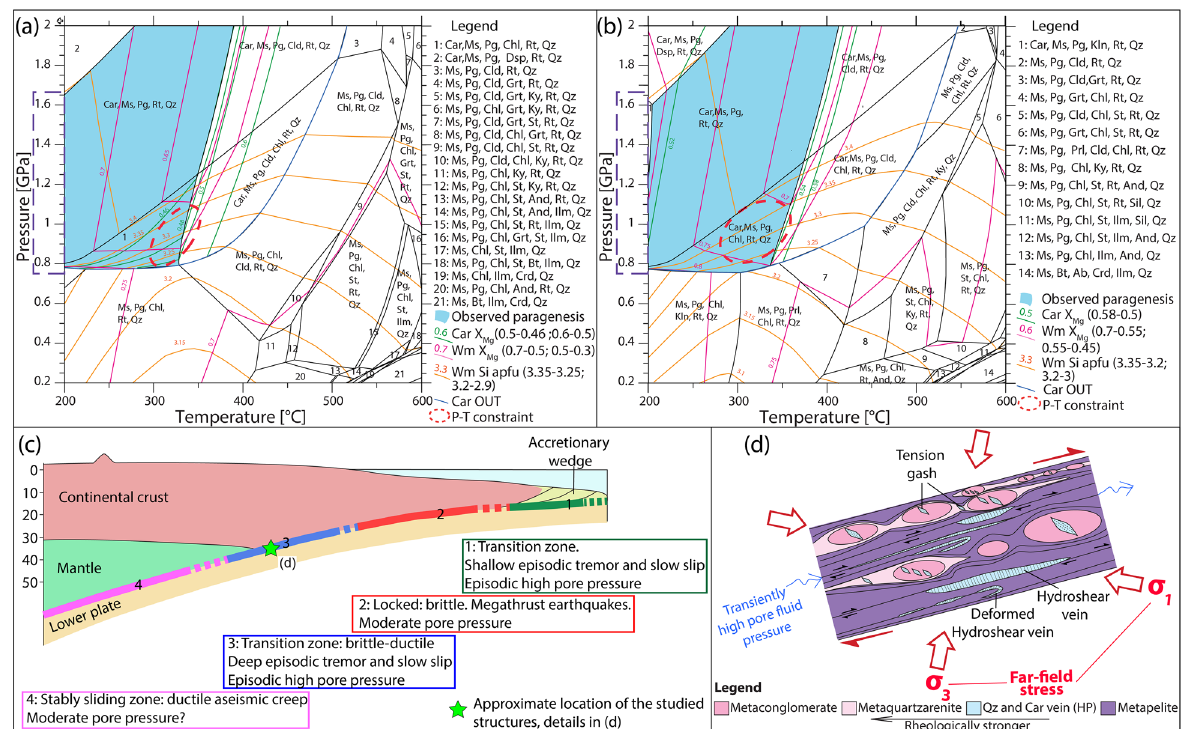
Figure 8. Thermodynamic modeling and conceptual sketch of the proposed geological record of ETS. ( a , b ) Equilibrium phase diagrams for quartz and carpholite dilational hydroshear vein (Sample A) and metapelite (Sample B), respectively. Red dashed ellipses indicate the P ‐ T conditions of the metamorphic stage best fitting the observed paragenesis and the computed isopleths. Pressure values corresponding to the depth range of deep ETS is indicated by the dashed violet rectangle (as constrained by 11 ) by the dashed rectangle along the P axis. ( c ) Sketch of the main slip modes occurring along a subduction zone with location of the studied ETS (based on 6 ). ( d ) Sketch of the proposed geological record of deep ETS (based on 36 ; created with Adobe Illustrator CS6 https:// www. adobe. com/ produ cts/ illus trator.